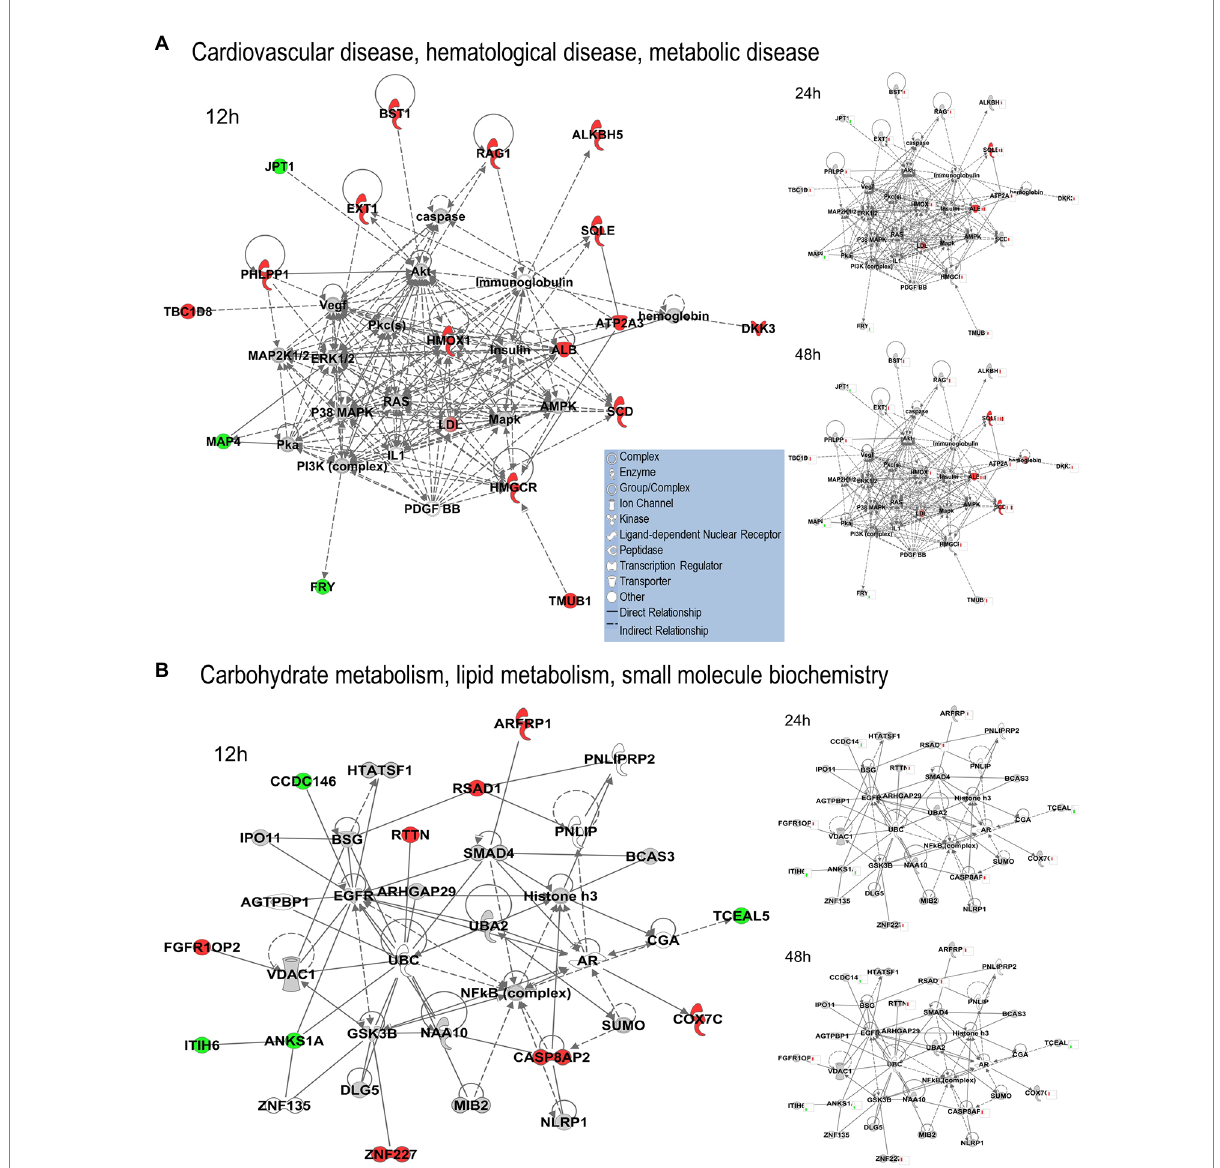
FIGURE 2 Top MRC-5 pathways affected by OC43 infection at 12 hpi. Proteins and their levels of dysregulation were uploaded into Ingenuity Pathway Analysis (IPA) and top pathways constructed. (A) The “cardiovascular disease, hematological disease, and metabolic disease” network. (B) The “carbohydrate metabolism, lipid metabolism, and small molecule biochemistry” network. Protein levels at 24 and at 48 hpi were overlaid onto these pathways (smaller diagrams at right). Upregulated proteins depicted in red, downregulated in green, insignificantly regulated in gray, direct interactions shown with solid lines, and indirect interactions depicted with dashed lines. Molecular types as indicated in